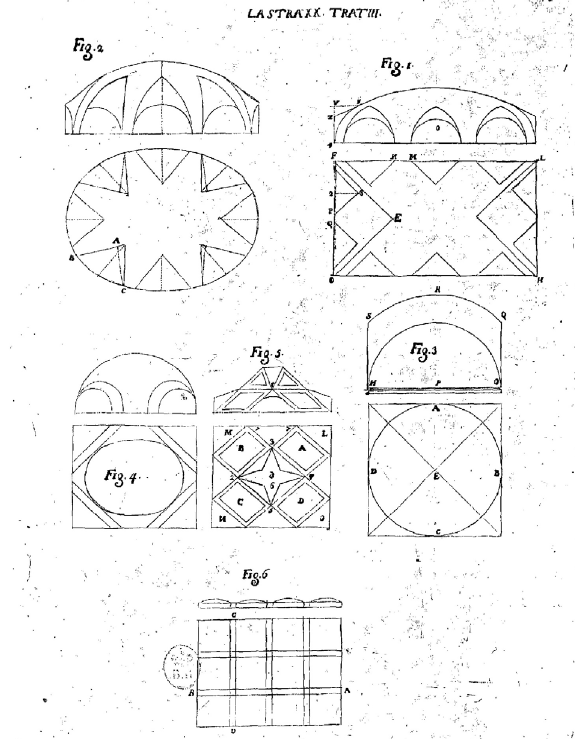
Figure 2 . Guarino Guarini, Architettura civile (1737). Trattato III, Lastra XX. Volte ‘a fascie’ (fig. 4) e volte ‘a fascie piane’ (fig.